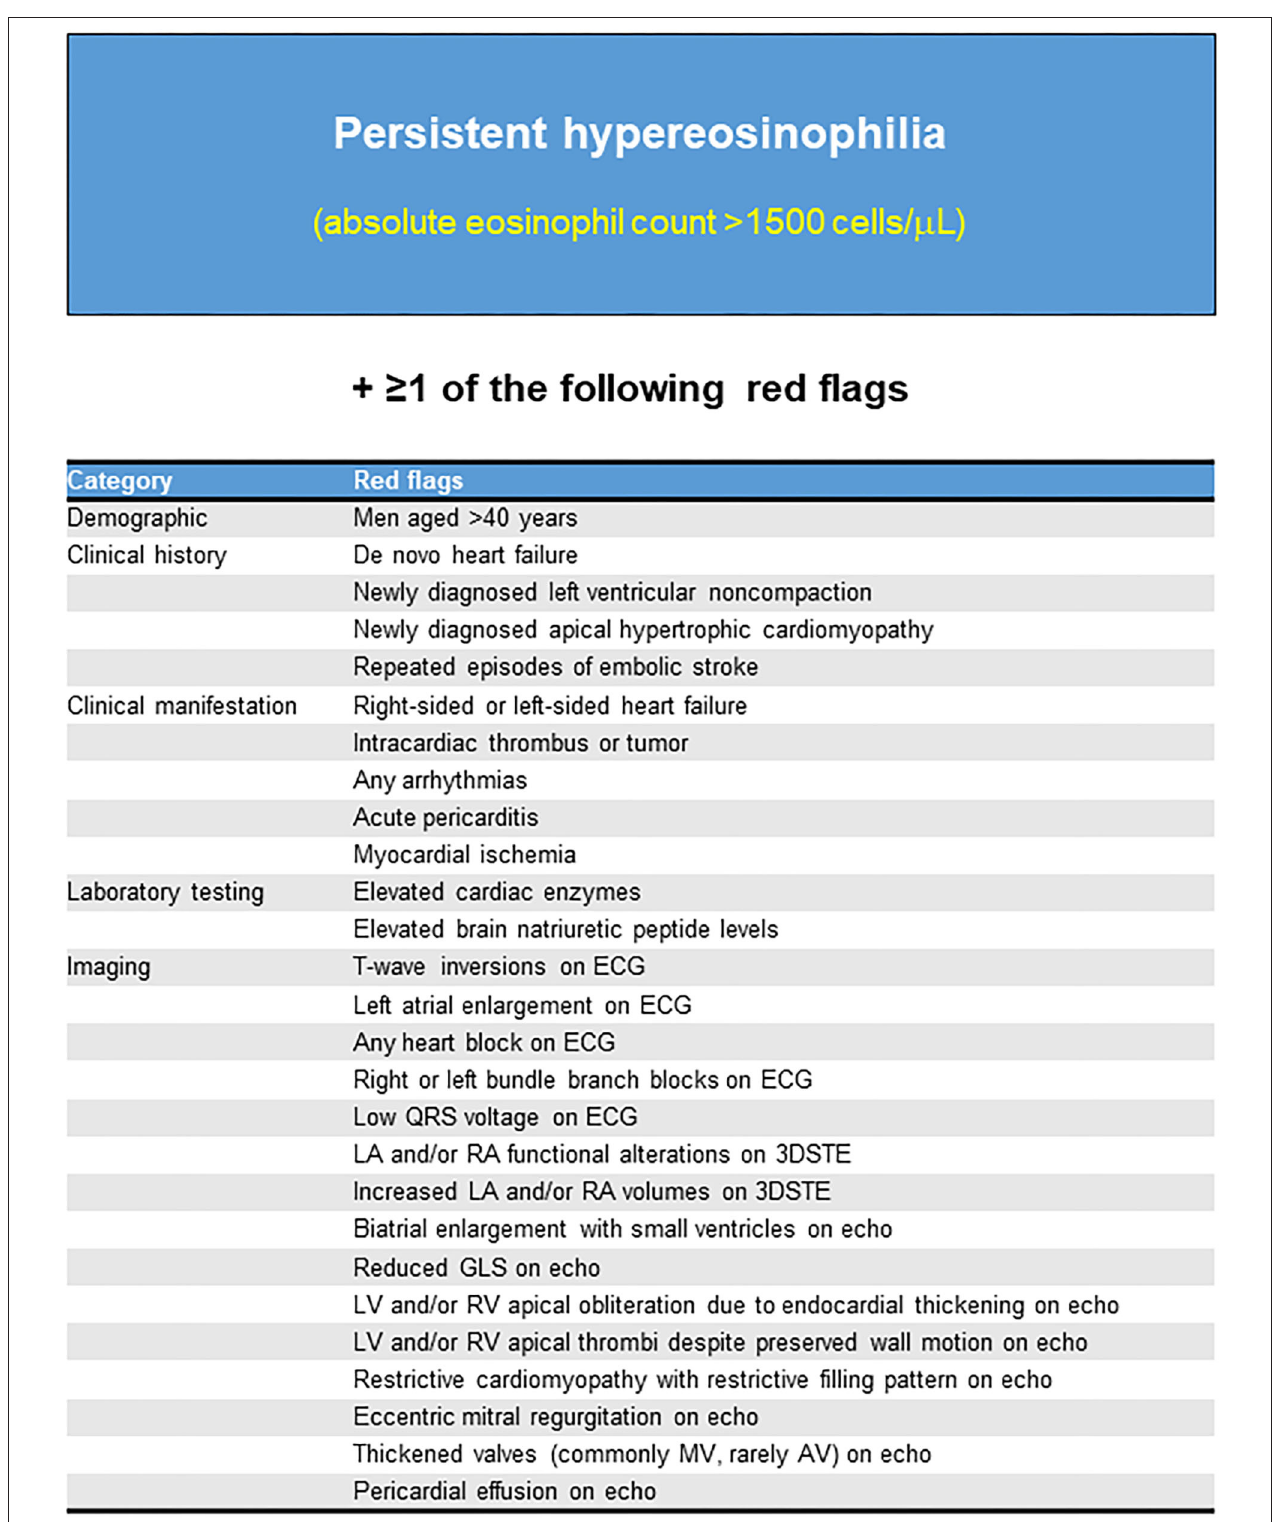
FIGURE 6 | Red flags that should be highly suspected of Löffler’s endocarditis. ECG, Electrocardiogram; Echo, Echocardiography; 3DSTE, Three-dimensional speckle tracking echocardiography; LA, Left atrium; RA, Right atrium; GLS, Global longitudinal strain; LV, Left ventricle; RV, Right ventricle; MV, mitral valve; AV, aortic valve.